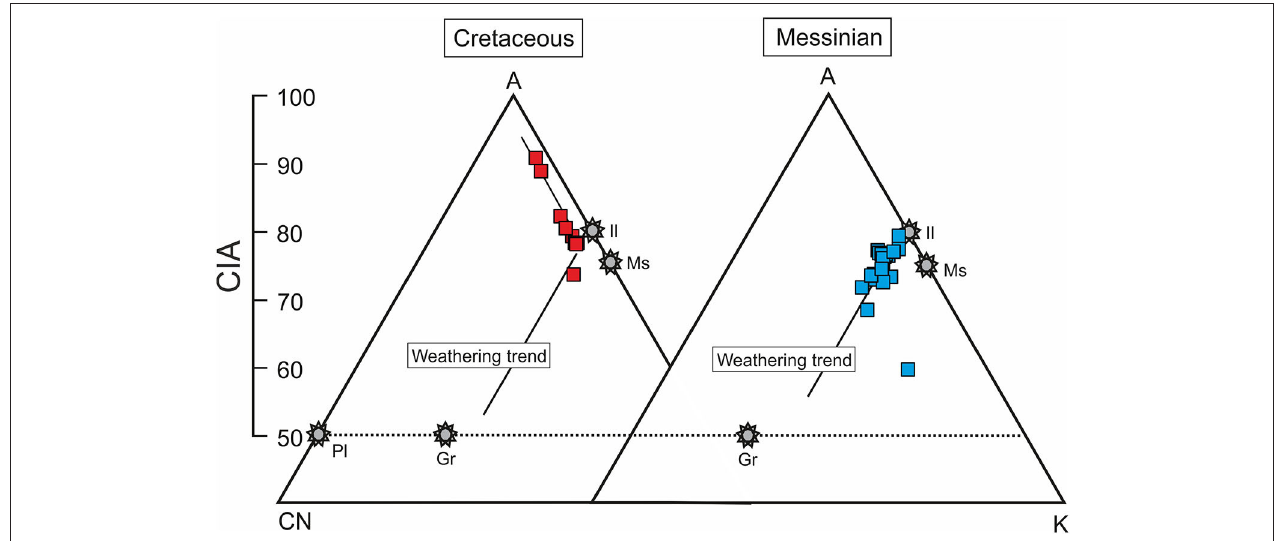
FIGURE 8 | A–CN–K diagram for the analyzed palaeosols. Pl, plagioclase; Gr, granite; Ms, muscovite; Il, illite. The Cretaceous sediments display a typical intense weathering trend, whereas the Messinian samples display a trend consistent with a moderate degree of weathering.